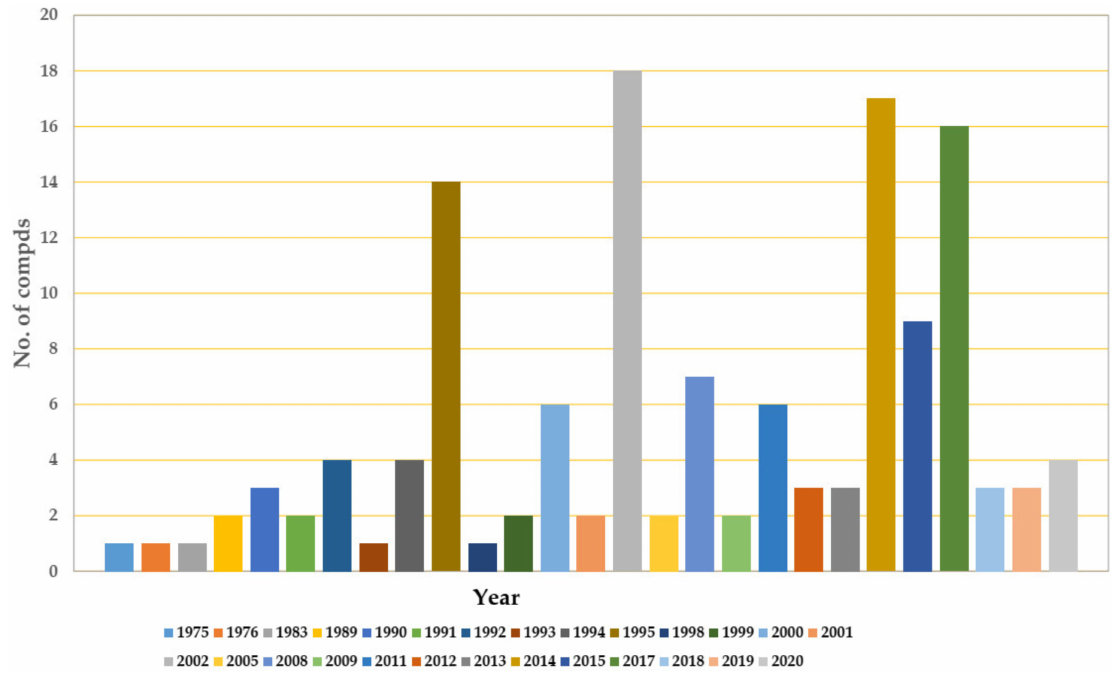
Figure 16. Annual numbers of isolated depsides, from 1975 to 2020. Most of the reported depsides have been evaluated for their α -GI ( α -glucosidase inhibitory), antimicrobial, antitumor, antifouling, PLA2 (phospholipase A2), and DGATI (diacylglycerol acyltransferase inhibitory) abilities (Figure 17). Thus, these studies revealed that fungal depsides are a rich source for the discovery of effective and novel pharmaceuti- cal leads and should be further